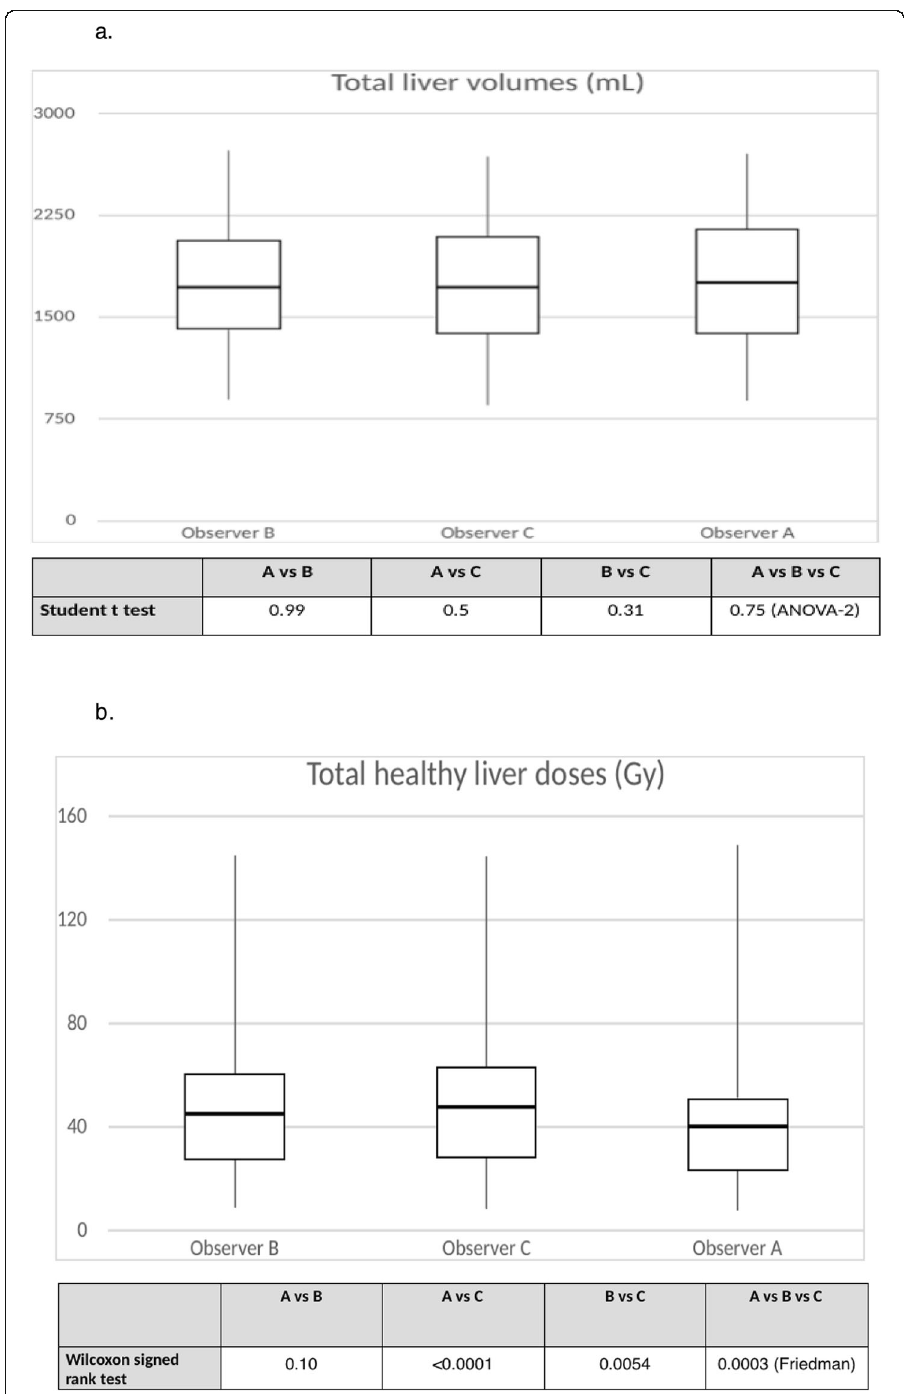
Fig. 1 (See legend on next